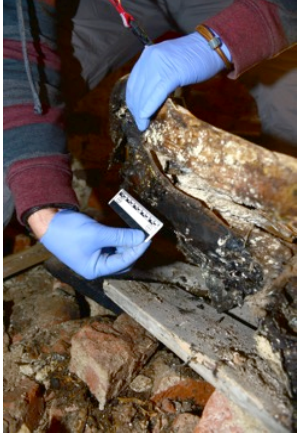
Figure 6. The state of preservation of the von Fahrenheid family remains (photo by H. Kowalski).